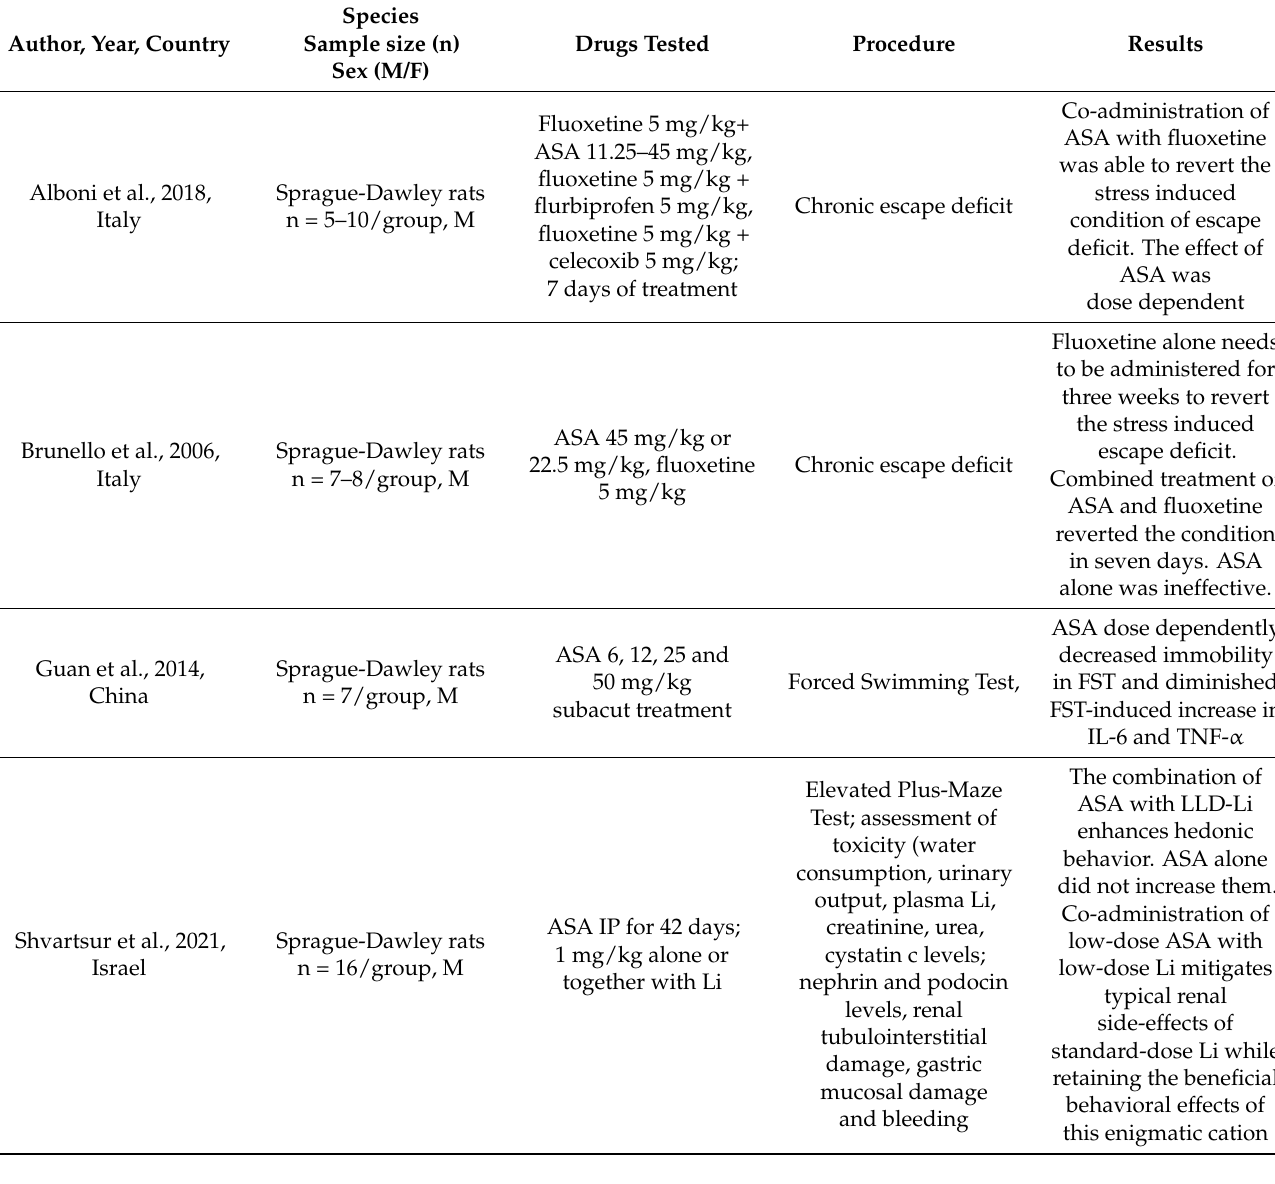
Figure 4. Risk of bias for interventional non-randomized study with ROBINS-I tool. A total of eight in vivo studies were identified (Table 2). Table 2. In Vivo Studies on ASA in Animal Models of Depression or